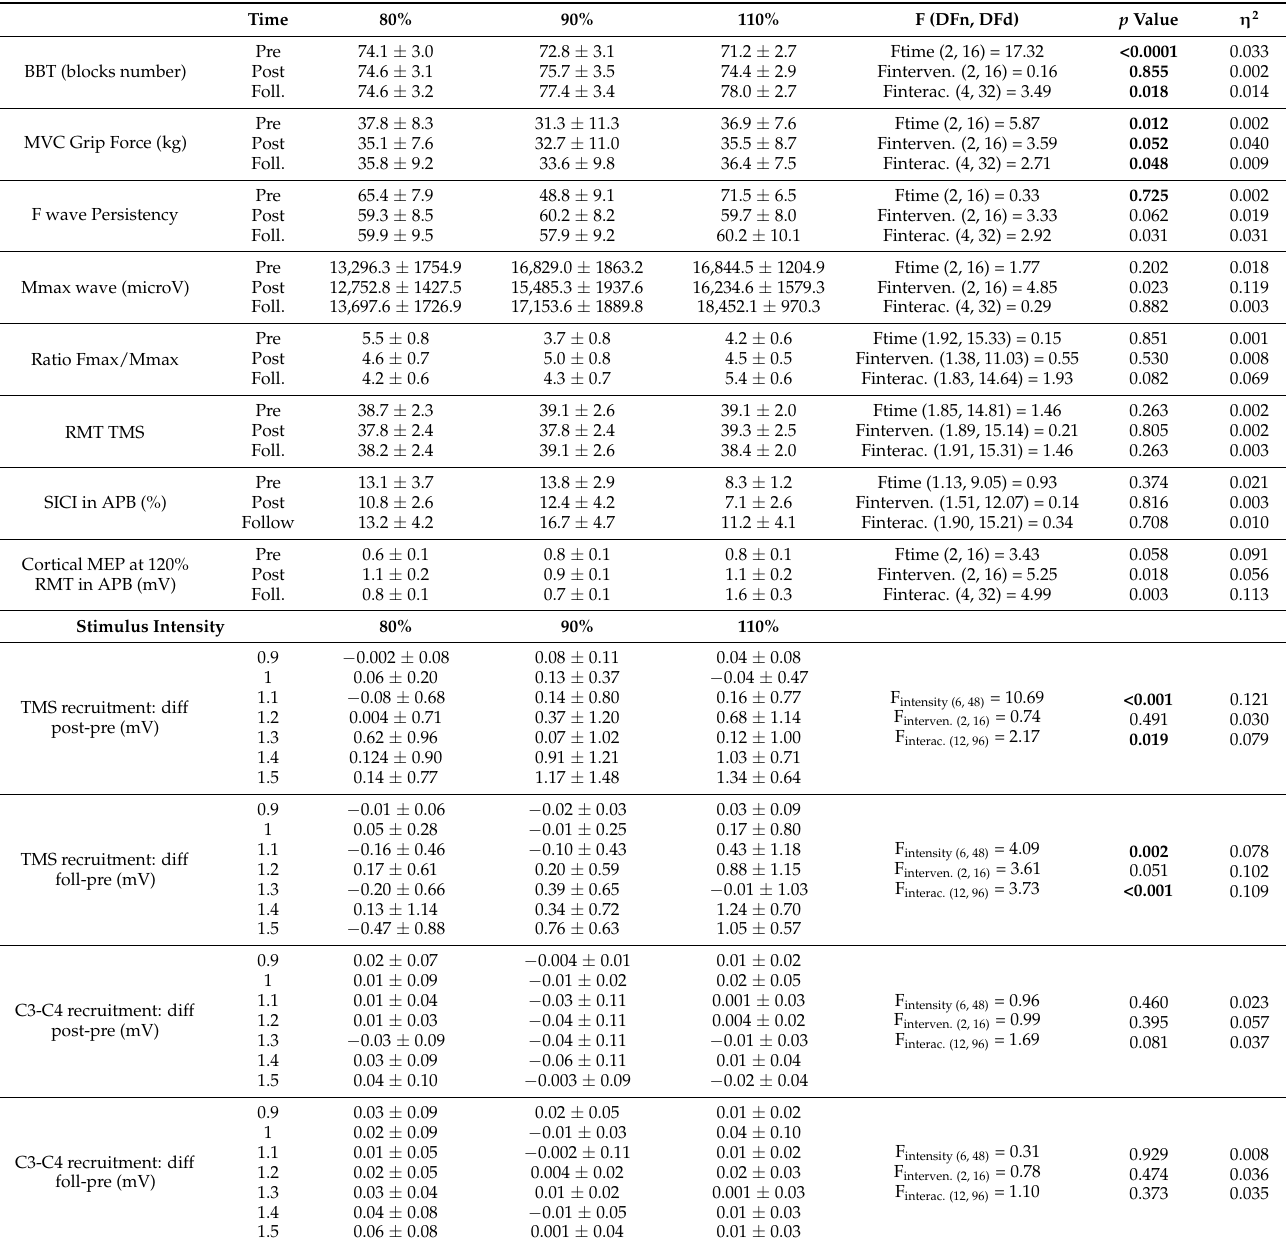
Table 3. Raw data and statistics of functional and motor strength and neurophysiological assessment during 100% or 50% of hand grip strength during hand training combined with the 90% of electrical stimulus intensity for